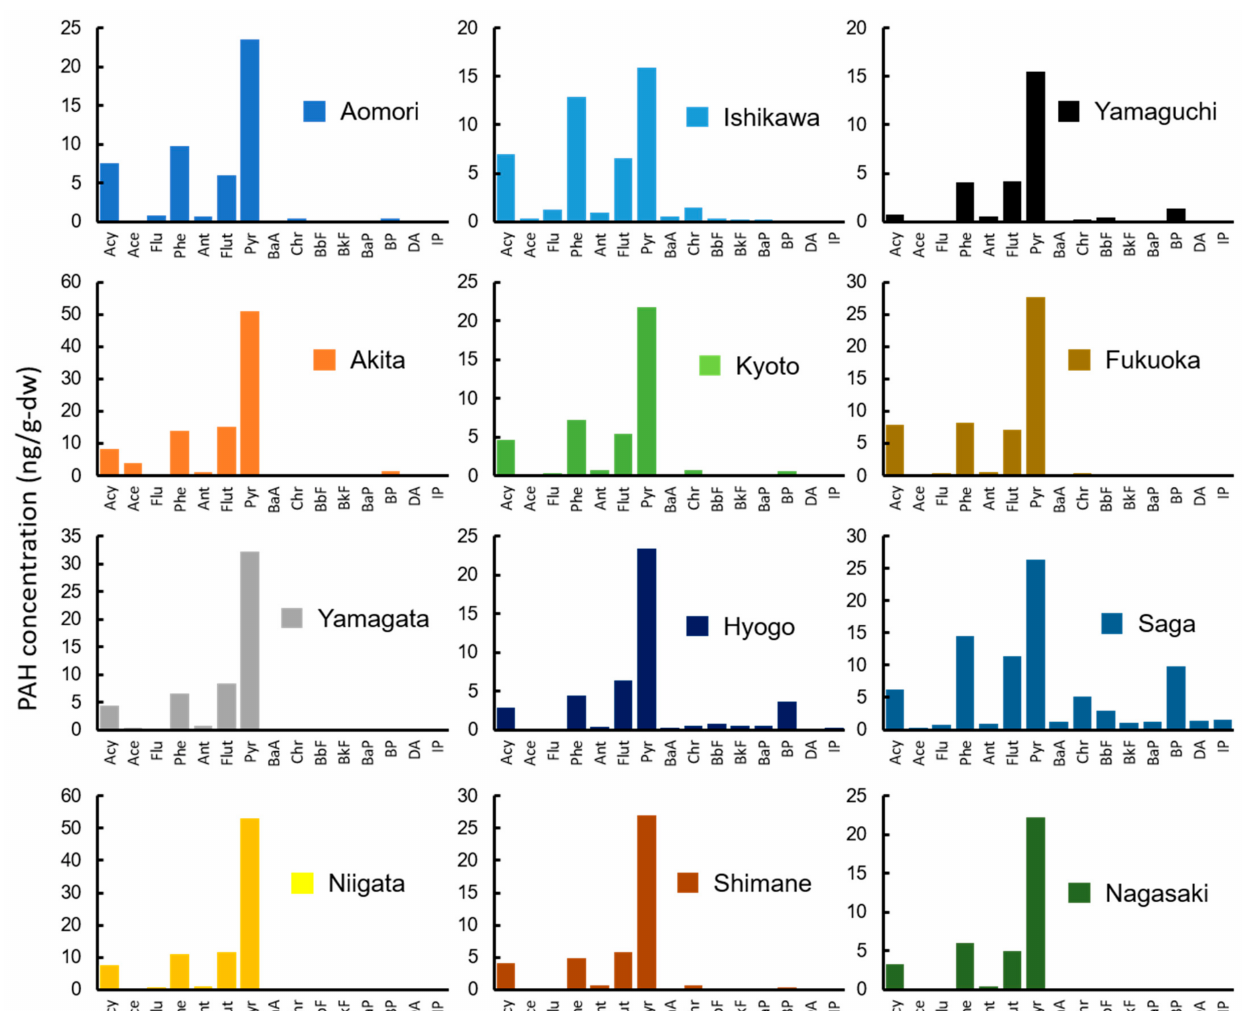
Figure 2. The concentrations of 15 PAHs in wharf roaches (ng/g-dw) collected from 12 sampling